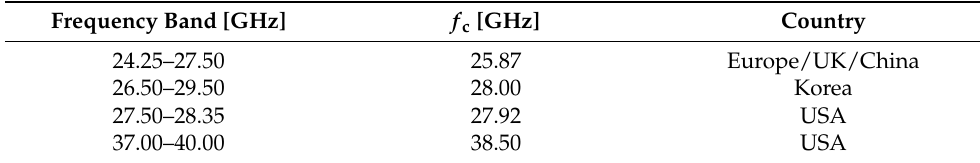
Table 1. 5G high frequency bands of some